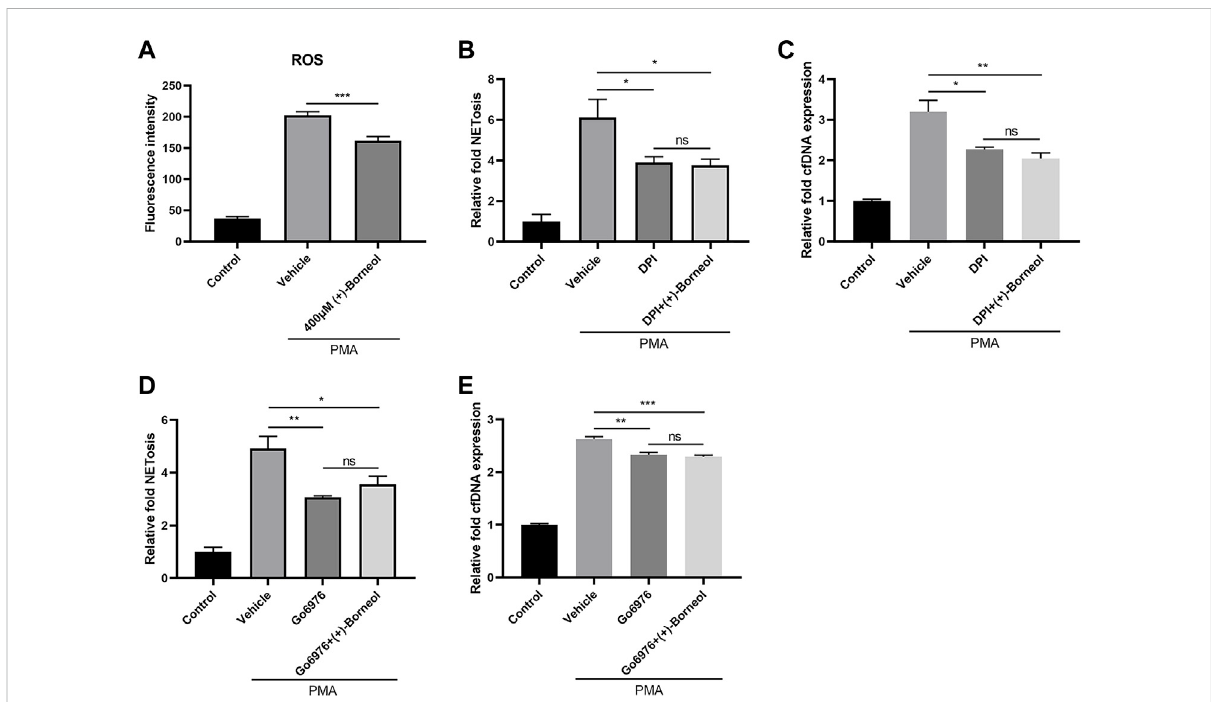
FIGURE 4 (+)-Borneol inhibits PMA-stimulated ROS generation. (A) ROS generation by neutrophils. ROS generation was measured in the presence or absence of(+)-borneol before PMAstimulation. n =4pergroup. (B – E) NETs andcfDNAproducedbyneutrophils. n =3pergroup. (B,C) Neutrophils were preincubated with 20 μ M DPI for 30 min, followed by being treated with or without (+)-borneol for another 30 min and then stimulated with PMA. (D,E) Neutrophils were pre-incubated with 1 μ M Go6976 for 30 min, followed by being treated with or without (+)-borneol for another 30 min and then stimulated with PMA. * p < 0.05, ** p < 0.01, and *** p < 0.001; ns = not signi fi